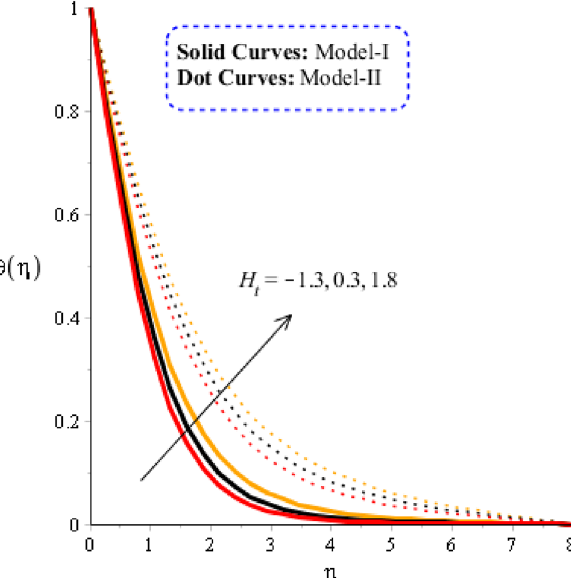
Figure 8. Graphical impact of H t on thermal distribution when α = 0.5, m = 0.3, Re = 4.0, we = 3.0, M = 3.0, Pr = 206, K c = − 3.0, Sc = 0.0, δ 1 = 0.4, ϕ 1 = 0.003, ϕ 2 = 0.004, ϕ 3 =